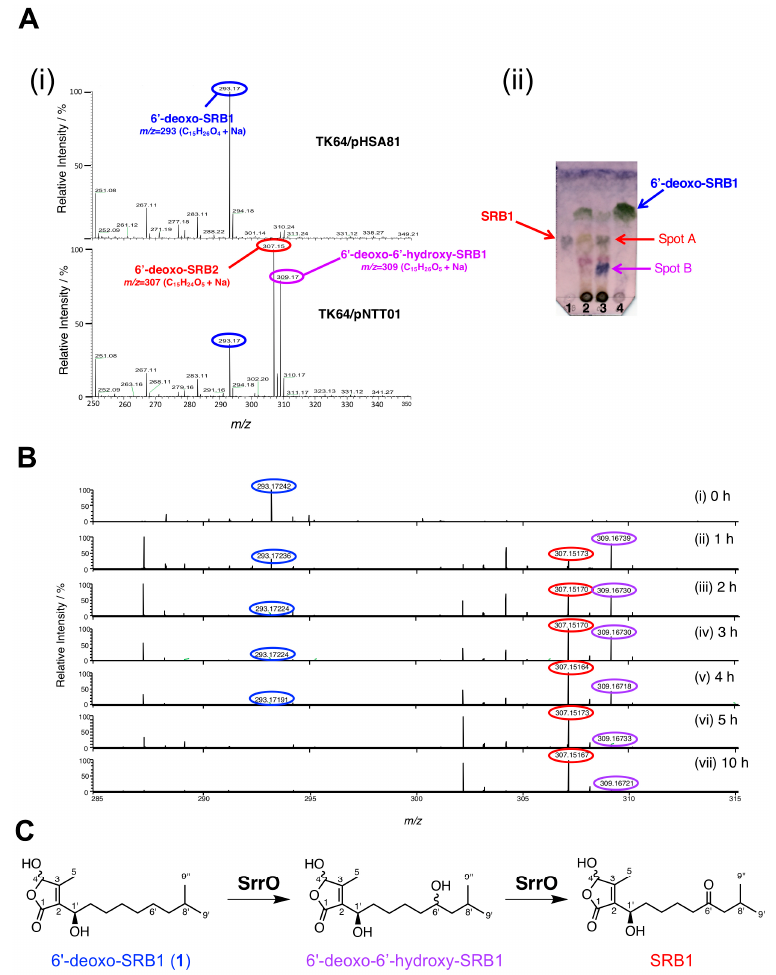
Figure 5. Enzymatic conversion of 6 (cid:48) -deoxo-SRB1 ( 1 ) by P450 monooxygenase SrrO in the Streptomyces lividans TK64 / pNTT01recombinant. ( A )( i )ESI-MSspectraofreactionmixturein S.lividans TK64 / pNTT01 ( + SrrO) (upper panel) and S. lividans TK64 / pHSA81 (control). ( ii ) TLC analysis of reaction mixture. Lane 1, the synthetic SRB1, lane 2, reaction mixture in S. lividans TK64 / pHSA81; lane 3, reaction mixture in S. lividans TK64 / pNTT01; lane 4, the synthetic 6 (cid:48) -deoxo-SRB1. TLC was developed with hexane-EtOAc = 1:2 ( v / v ), and baked after staining with anisaldehyde. ( B ) ESI-MS spectra of time-course enzymatic conversion of 6 (cid:48) -deoxo-SRB1. Samples were collected at 0, 1, 2, 3, 4, 5, and 10 h periods. ( C ) Scheme for two-stage oxidation of 6 (cid:48) -deoxo-SRB1 by